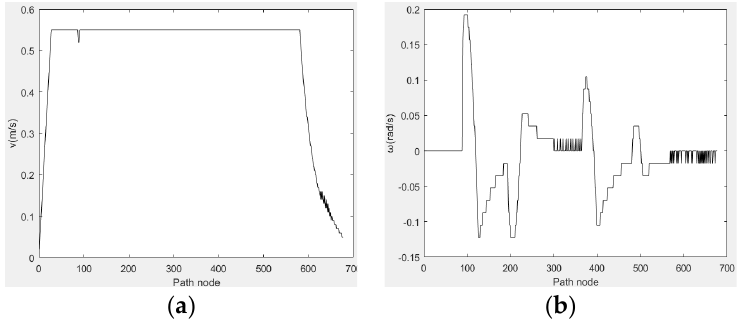
Figure 16. Speed variation in robot’s movement. ( a ) Line Speed, ( b ) Angular velocity.